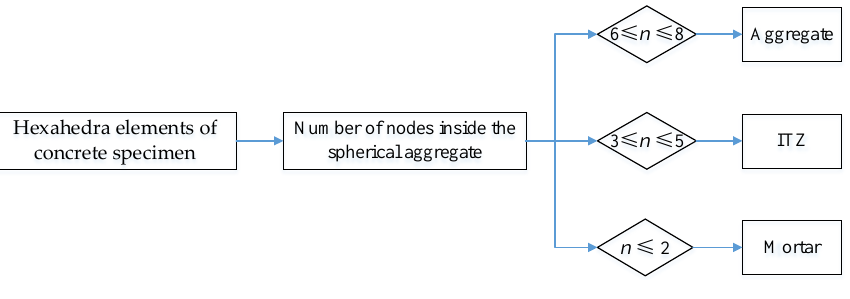
Figure 1. Classification principle of each phase.